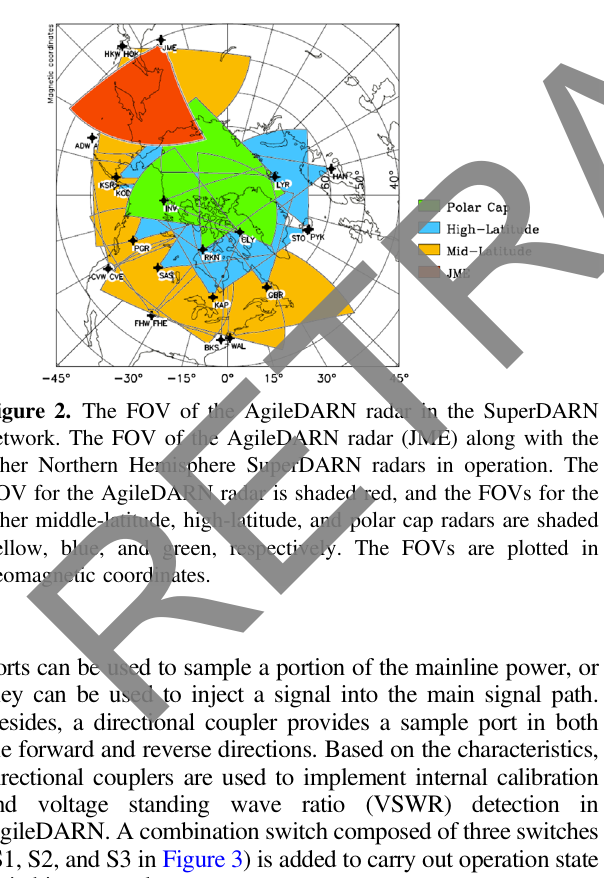
Figure 1. Simpli fi ed block diagram of the AgileDARN radar. It is composed of two arrays with 20 antennas, 20 individual transceivers, a digital processing unit (DPU), and a computer.